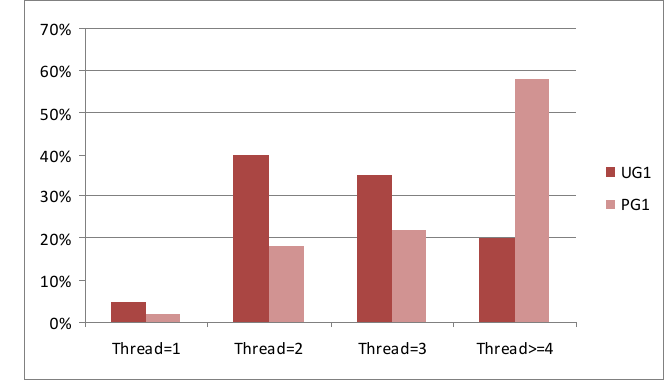
Figure 5: Depth of Interactions in the Online Discussion Forums in WawasanLearn